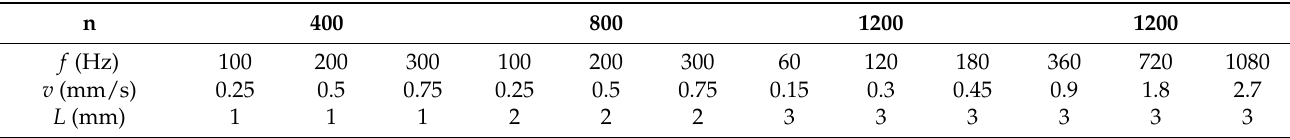
Table 3. Comparison of Opening-closing displacement and speed results for different